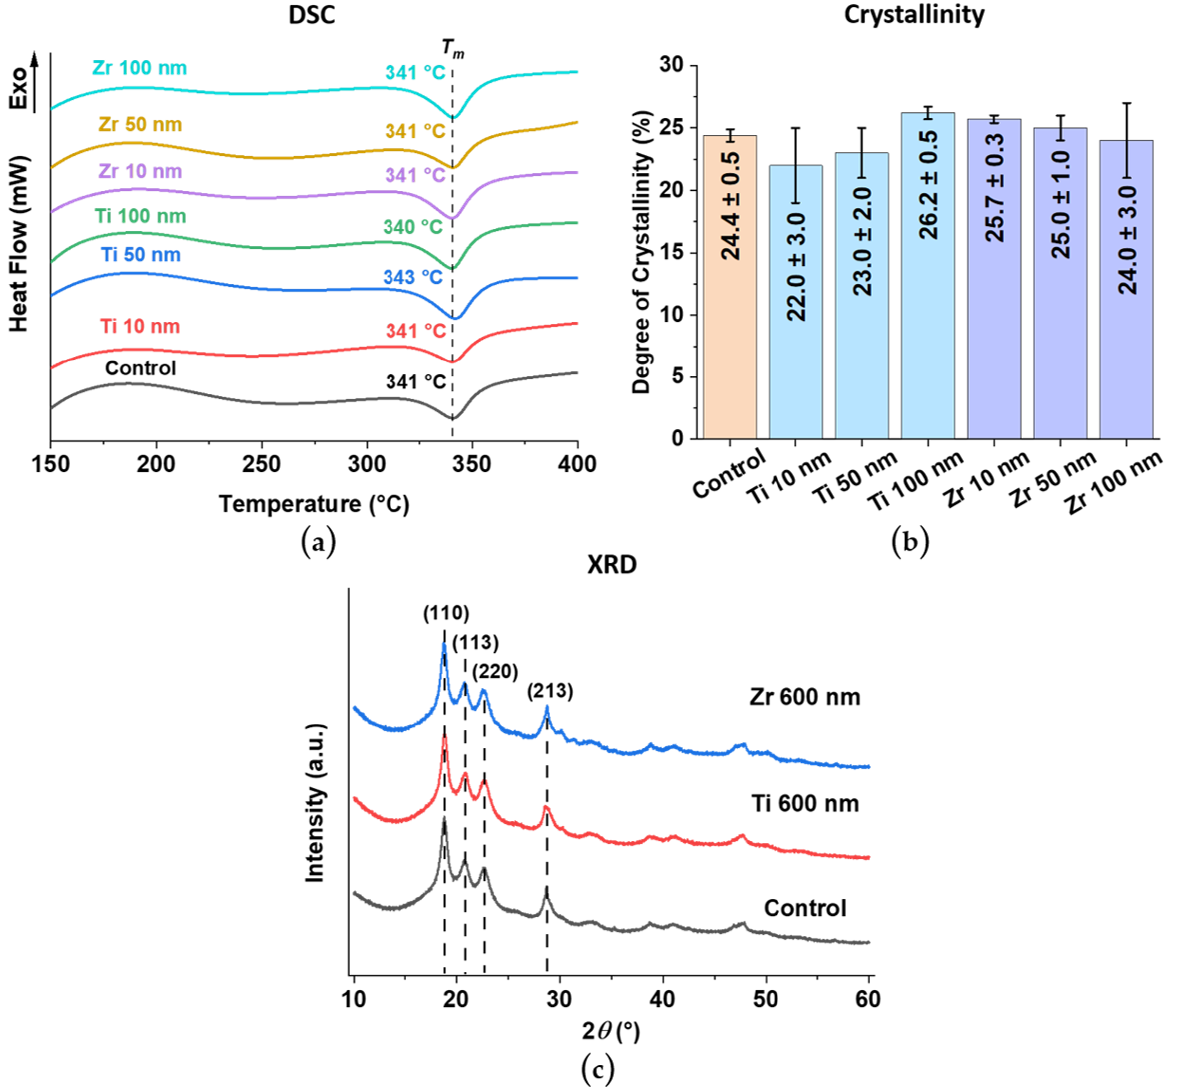
Figure 5. Crystallinity determination for all investigated PEEK samples. ( a ) Differential scanning calorimetry (DSC) thermograms with the melting temperature ( T m ) indicated. ( b ) Degree of crystallinity ( X c ) calculated from the DSC results using Equation (1) (see Chapter 2.3). ( c ) X-ray diffraction (XRD) spectra for unmodified control samples and surface-modified PEEK samples with a coating thickness of 600 nm.